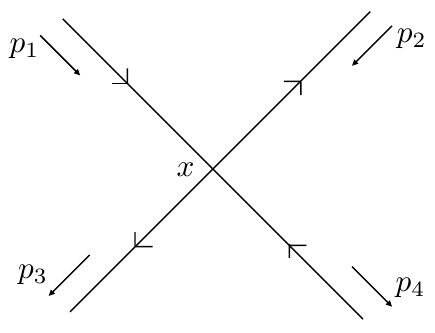
Figure 1 . Tree-level diagram that contributes to the S -matrix at first